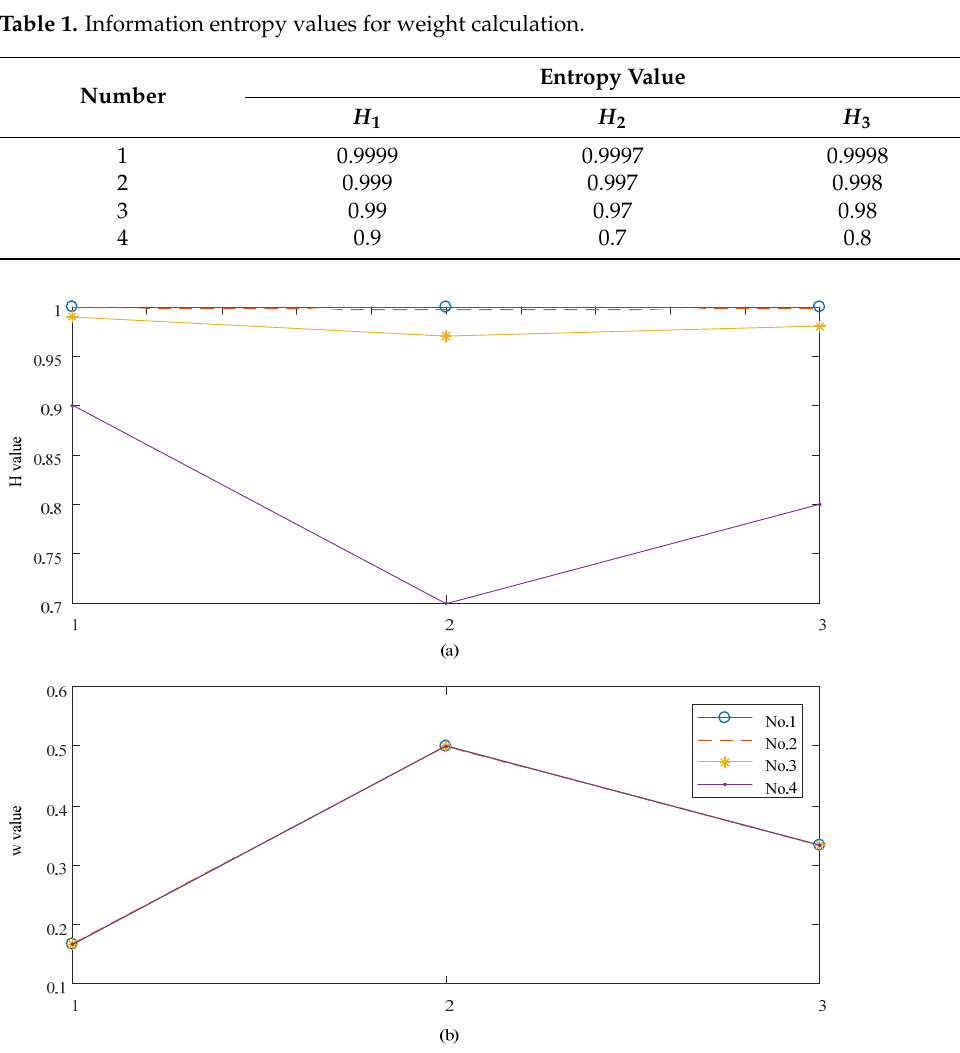
Figure 2. ( a ) H values of four sets. ( b ) Traditional information entropy weight values of four sets.